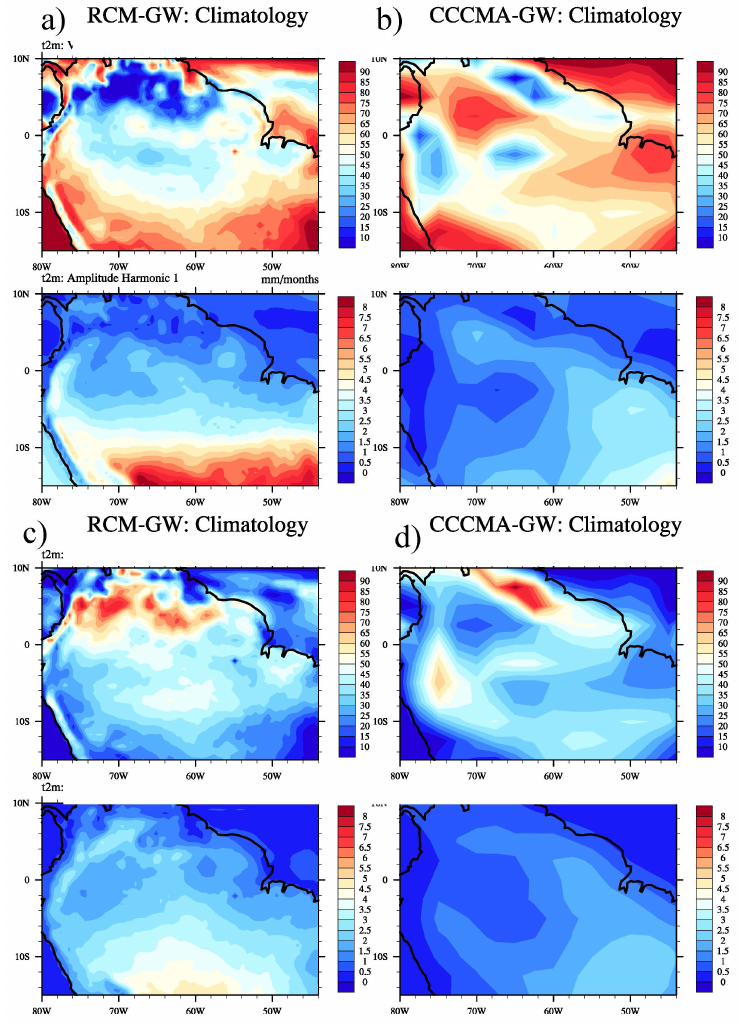
Figure 5. Variance of the first harmonic (%) based on GW-RCM simulation for t2m (a upper panel) and for the CCCMA-GW simulation (b upper panel). Lower panels of ( a , b ) show the first harmonic amplitude. ( c , d ) are the same as ( a , b ) but for the second